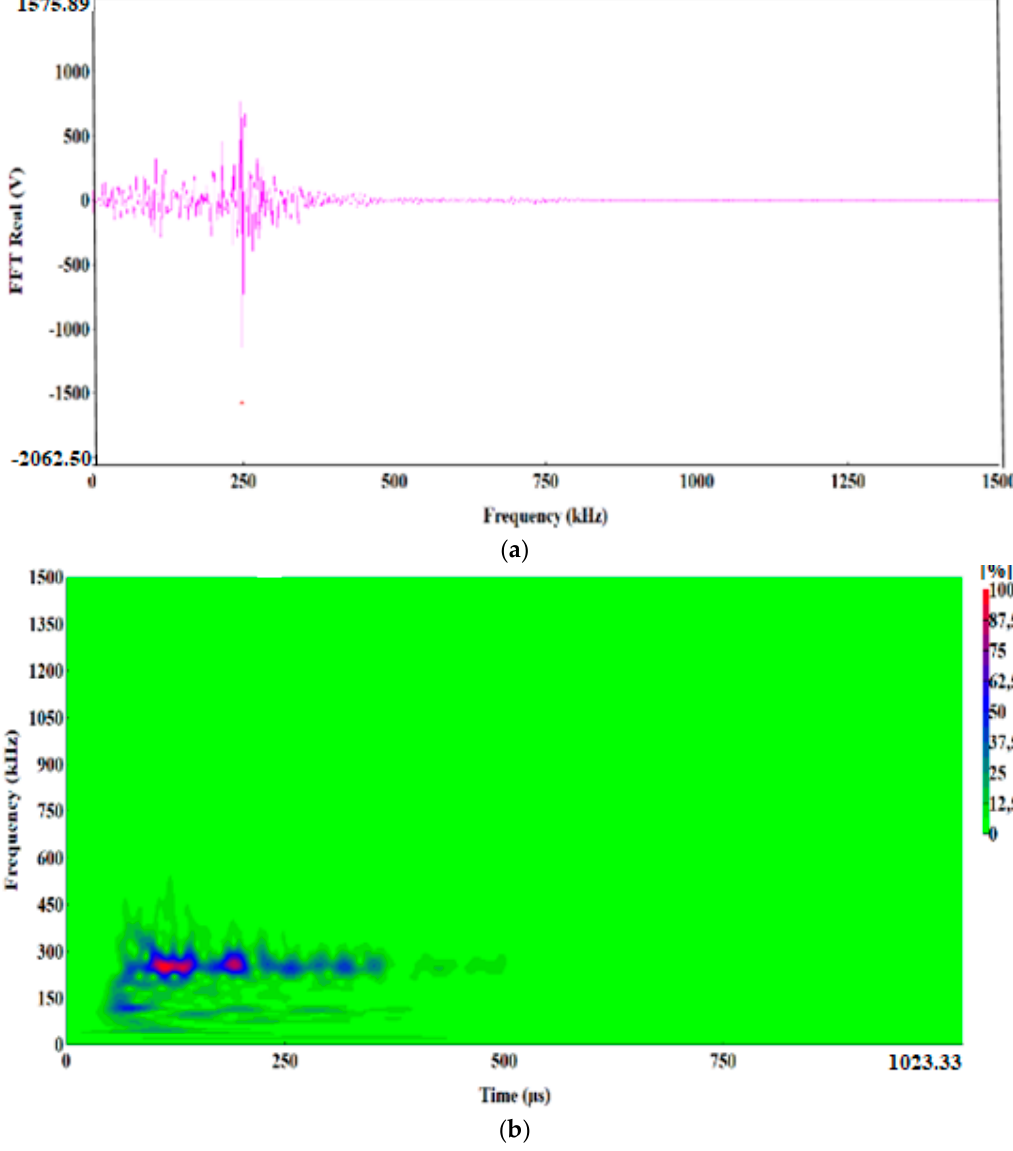
Figure 12. Waveform drequency domain (Real) ( a ) and waveform continuous wavelet (Morlet) ( b ) charts for the individual classes of AE signals (class 3).